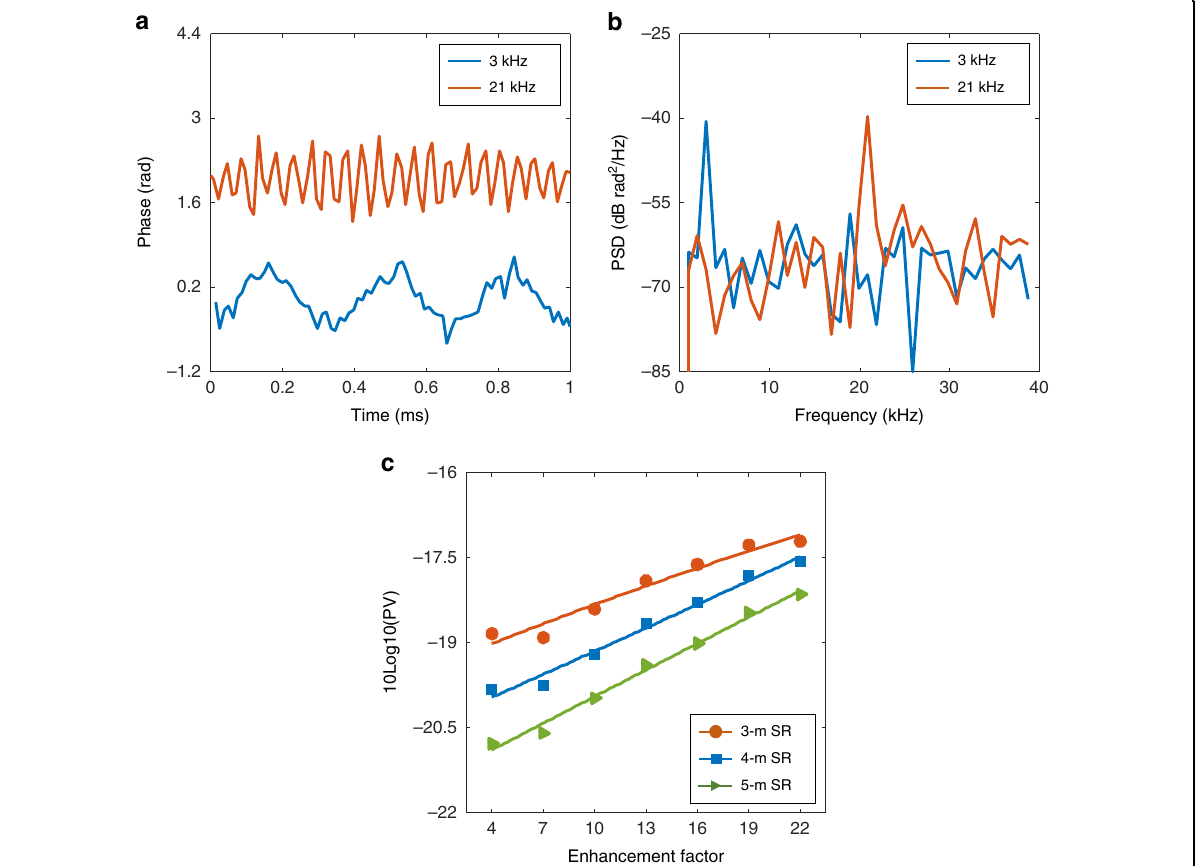
Fig. 6 Characteristics of the frequency response enhancement. a The time-domain waveforms of 3 kHz and 21 kHz vibrations and b the corresponding PSDs. c The effect of enhancement factor (EF) on the sensing accuracy with different spatial resolutions